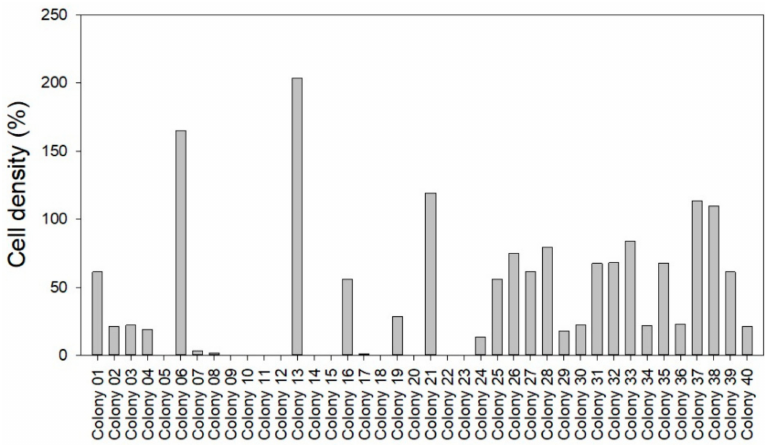
Figure 8. Quantification of phage KVP40-induced inhibition/promotion of cell growth in cultures of bacteria isolated from water used for transport of eggs used in turbot challenge trial 1. Phage-induced growth inhibition/promotion was determined as the percent cell density in cultures added phage KVP40 relative to control cultures without phage KVP40 (100%) after 3 h